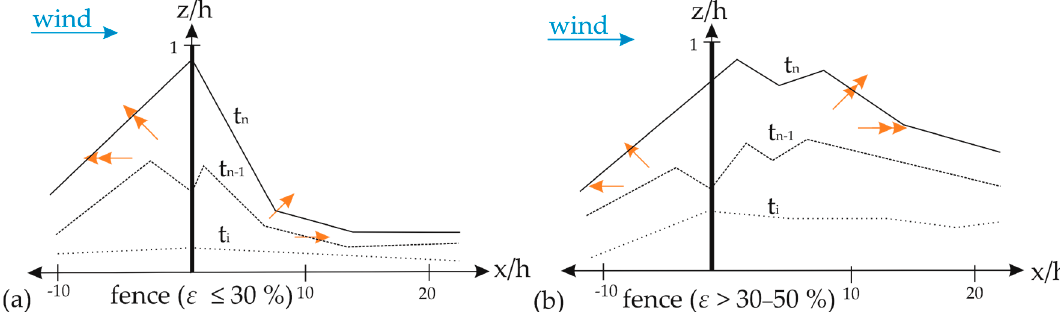
Figure 7. Schematic sketch showing dune establishment for fences with porosity of ( a ) ε ≤ 30%, and ( b ) ε > 30 − 50%. Dune establishment is shown over time, starting at timestep t i (shortly after starting experiment) until t n (end of experiment); timesteps shown correspond to fences with different porosity values. Arrows show areas with dune growth and their corresponding directions; double arrows show areas with comparatively stronger growth (adapted from [17,22]).